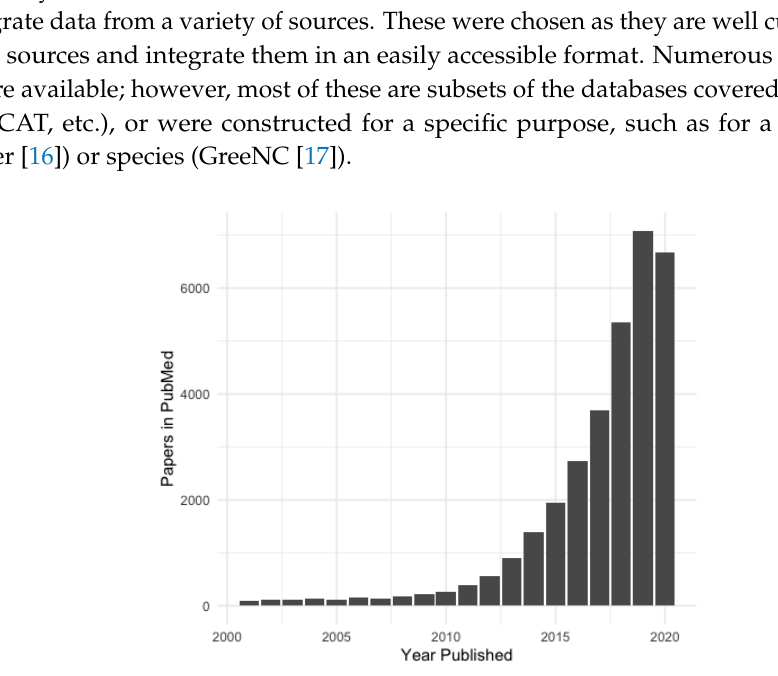
Figure 2. Number of lncRNA papers published from 2001. Identified by keyword, accessed